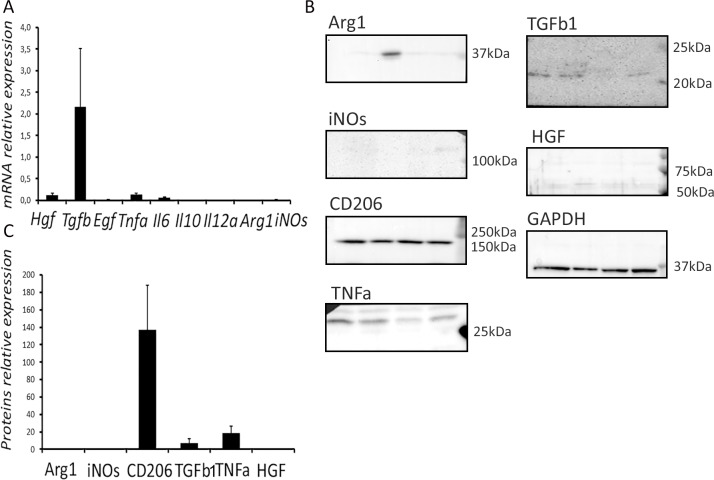
Profiles of gene (A) and protein expression (B,C) in the spleen. Visual assessment of the western blot was followed by quantitative densitometry. The data are represented as mean values ± SD.